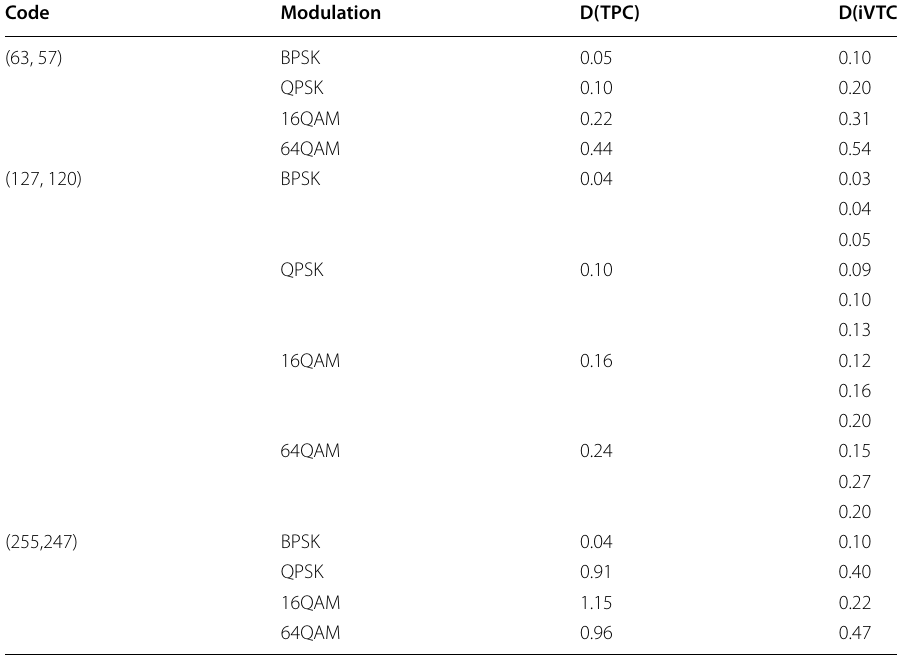
Table 4 Distance to capacity in bits per channel use for TPC and iVTC